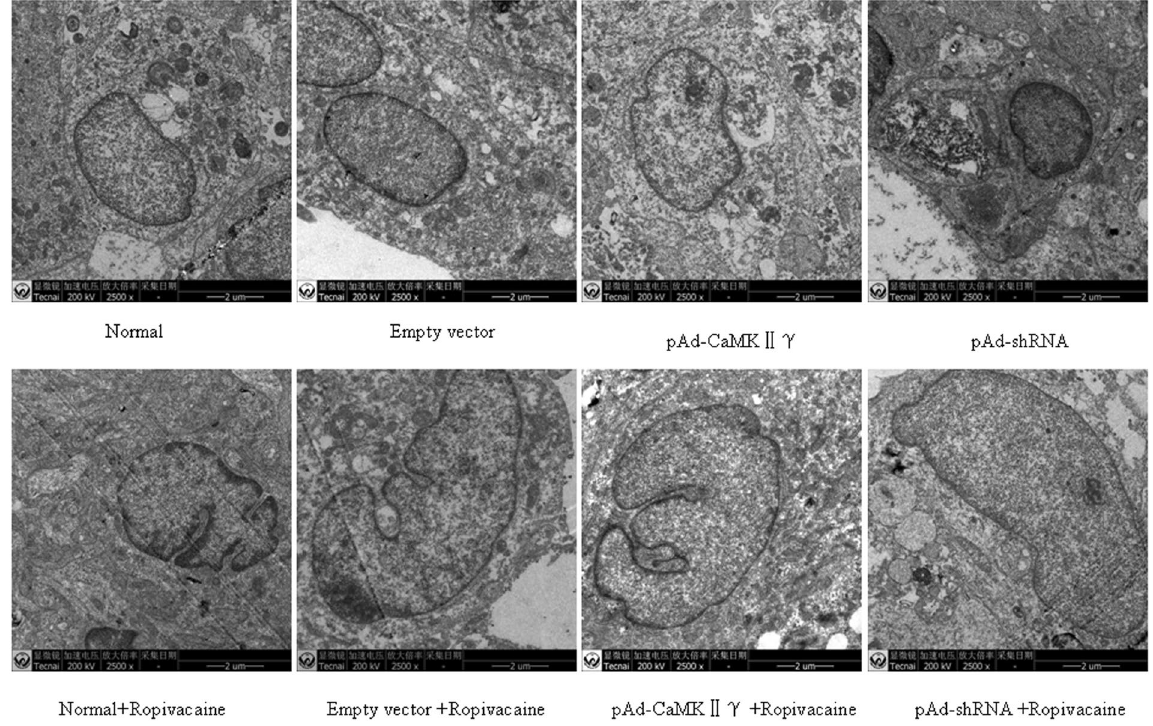
Figure 4. Ultrastructural changes in cells in each group using transmission electron microscopy (200w, ×